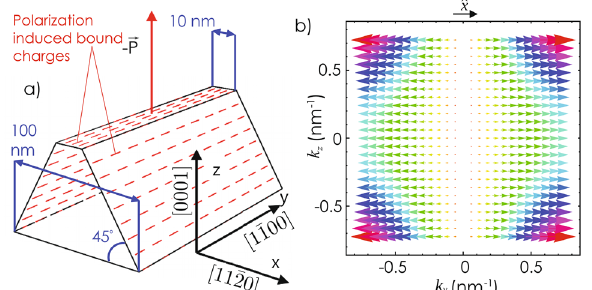
Figure 1. ( a ) Schematic representation of the nanowedge structure. Growth [0001] and confinement [ 11 ¯ 20 ] ( a -axis) directions are regarded as z and x -axes, respectively. ( b ) Arrows represent the direction and magnitude of the effective field �( k ) seen by the conduction band electrons with wave-vector k in the 2DEG